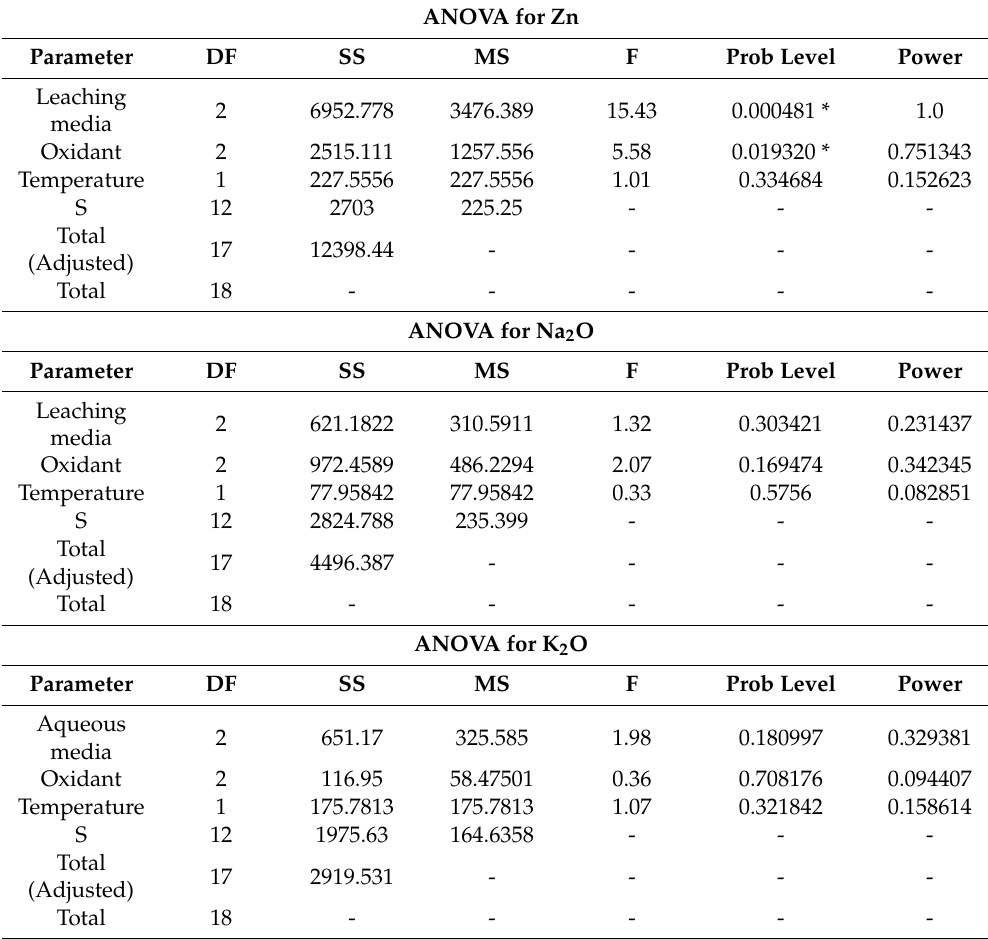
Table 5. Analysis of variance (ANOVA) for Zn, Na 2 O and K 2 O removal from blast furnace